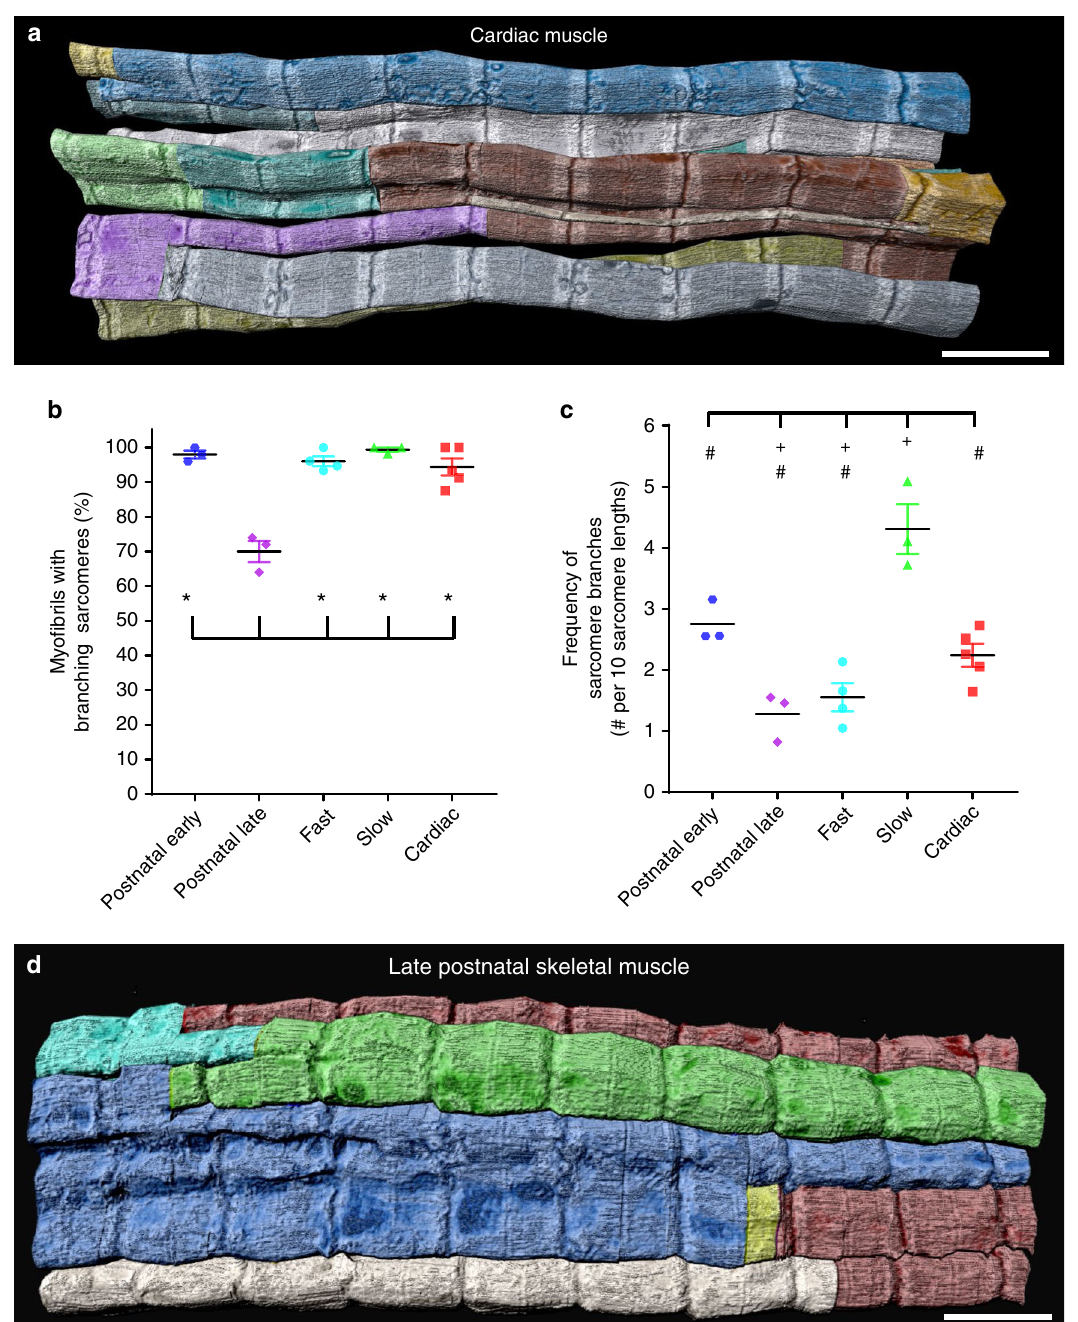
Fig. 2 Sarcomere branching is extensive, but variable across muscle types and developmental stages. a 3D rendering of 77 directly connected sarcomeres within the myo fi brillar matrix of a cardiac muscle fi ber. Individual colors represent different myo fi brillar segments linked by branching sarcomeres. b Percentage of myo fi brils with at least one branching sarcomere in different muscle fi ber types. N values: postnatal early — 141 myo fi brils, 1796 sarcomeres, 3 muscles, 3 mice; postnatal late — 150 myo fi brils, 1401 sarcomeres, 3 muscles, 3 mice; fast twitch — 468 myo fi brils, 7707 sarcomeres, 4 muscles, 3 mice; slow twitch — 299 myo fi brils, 3990 sarcomeres, 3 muscles, 3 mice; cardiac — 344 myo fi brils, 4473 sarcomeres, 5 muscles, 5 mice. c Frequency of sarcomere branching across muscle type. N values: postnatal early — 141 myo fi brils, 1796 sarcomeres, 3 muscles, 3 mice; postnatal late — 150 myo fi brils, 1401 sarcomeres, 3 muscles, 3 mice; fast twitch — 193 myo fi brils, 3477 sarcomeres, 4 muscles, 3 mice; slow twitch — 110 myo fi brils, 1396 sarcomeres, 3 muscles, 3 mice; cardiac — 167 myo fi brils, 2114 sarcomeres, 5 muscles, 5 mice. d 3D rendering of 43 directly connected sarcomeres within the myo fi brillar matrix of a late neonatal (P14) muscle fi ber. Individual colors represent different myo fi brillar segments linked by branching sarcomeres. Representative of three muscles from three mice. Scale bars, 2 µ m. Plus sign ( + ): Signi fi cantly different (one-way ANOVA, P < 0.05) from postnatal early. Asterisk (*): Signi fi cantly different from postnatal late. Pound sign (#): Signi fi cantly different from slow. Values: mean ±